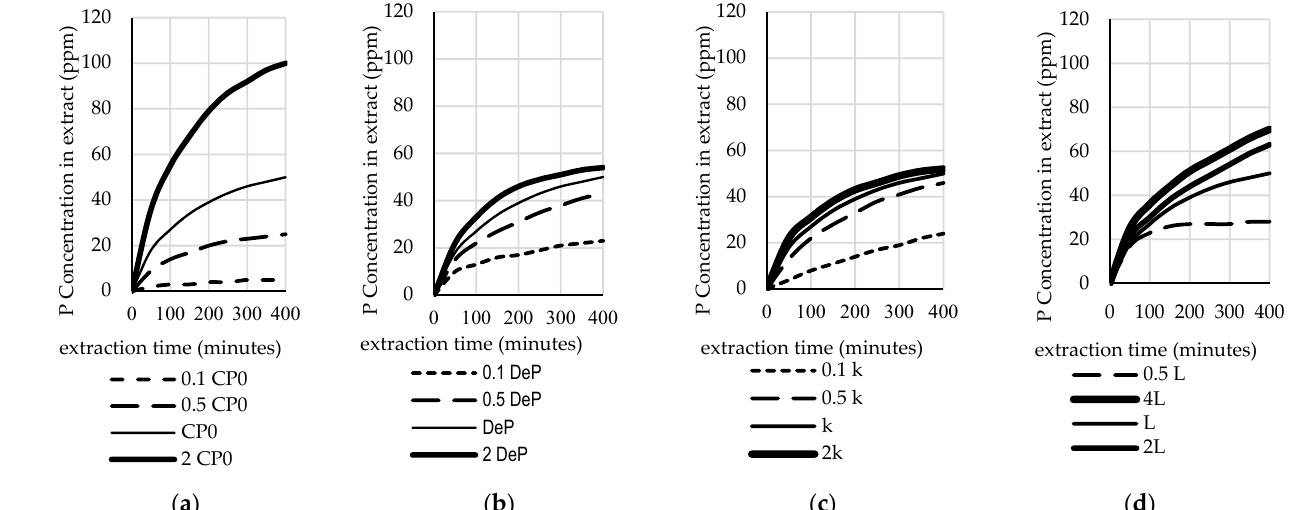
Figure 5. The effect of the: ( a ) initial P concentration in the pericarp; ( b ) effective diffusivity; ( c ) mass transfer coefficient; and, ( d ) slab thickness on the P concentration Figure 5. The e ff ect of the: ( a ) initial P concentration in the pericarp; ( b ) e ff ective di ff usivity; ( c ) mass transfer coe ffi cient; and, ( d ) slab thickness on the P concentration in the extract. in the